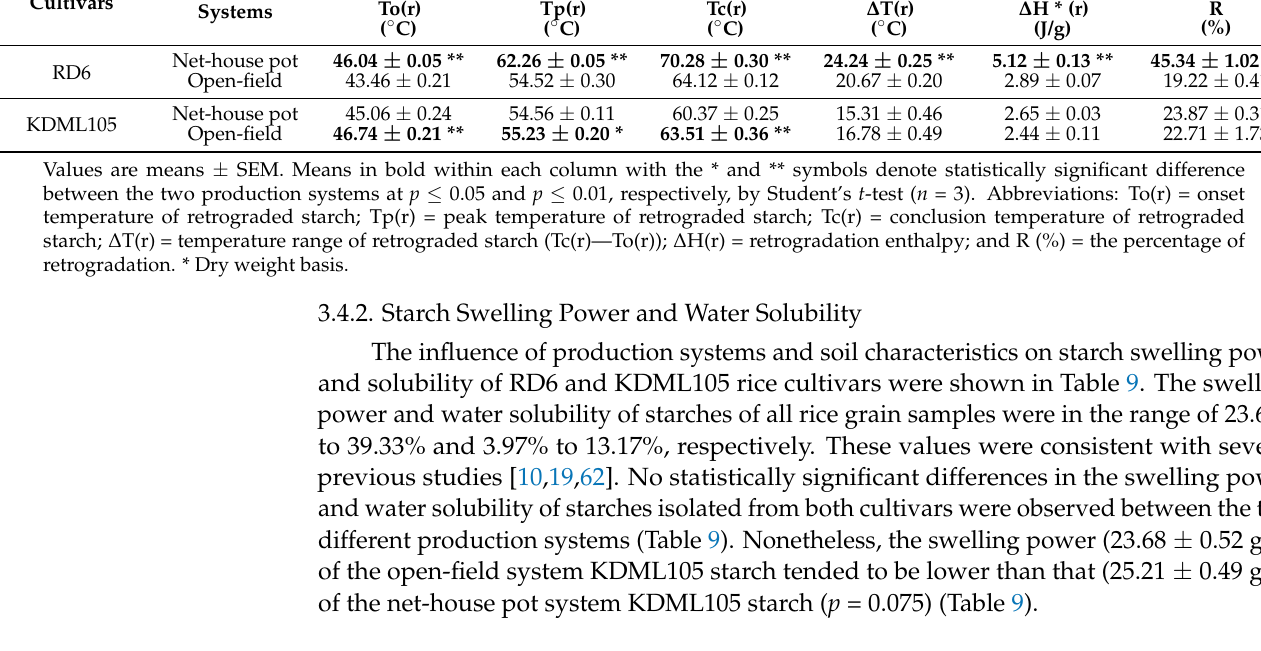
Table 9. Swelling power, solubility, and pasting properties of starches from the two elite Thai rice cultivars grown in the net-house pot and open-field production systems.